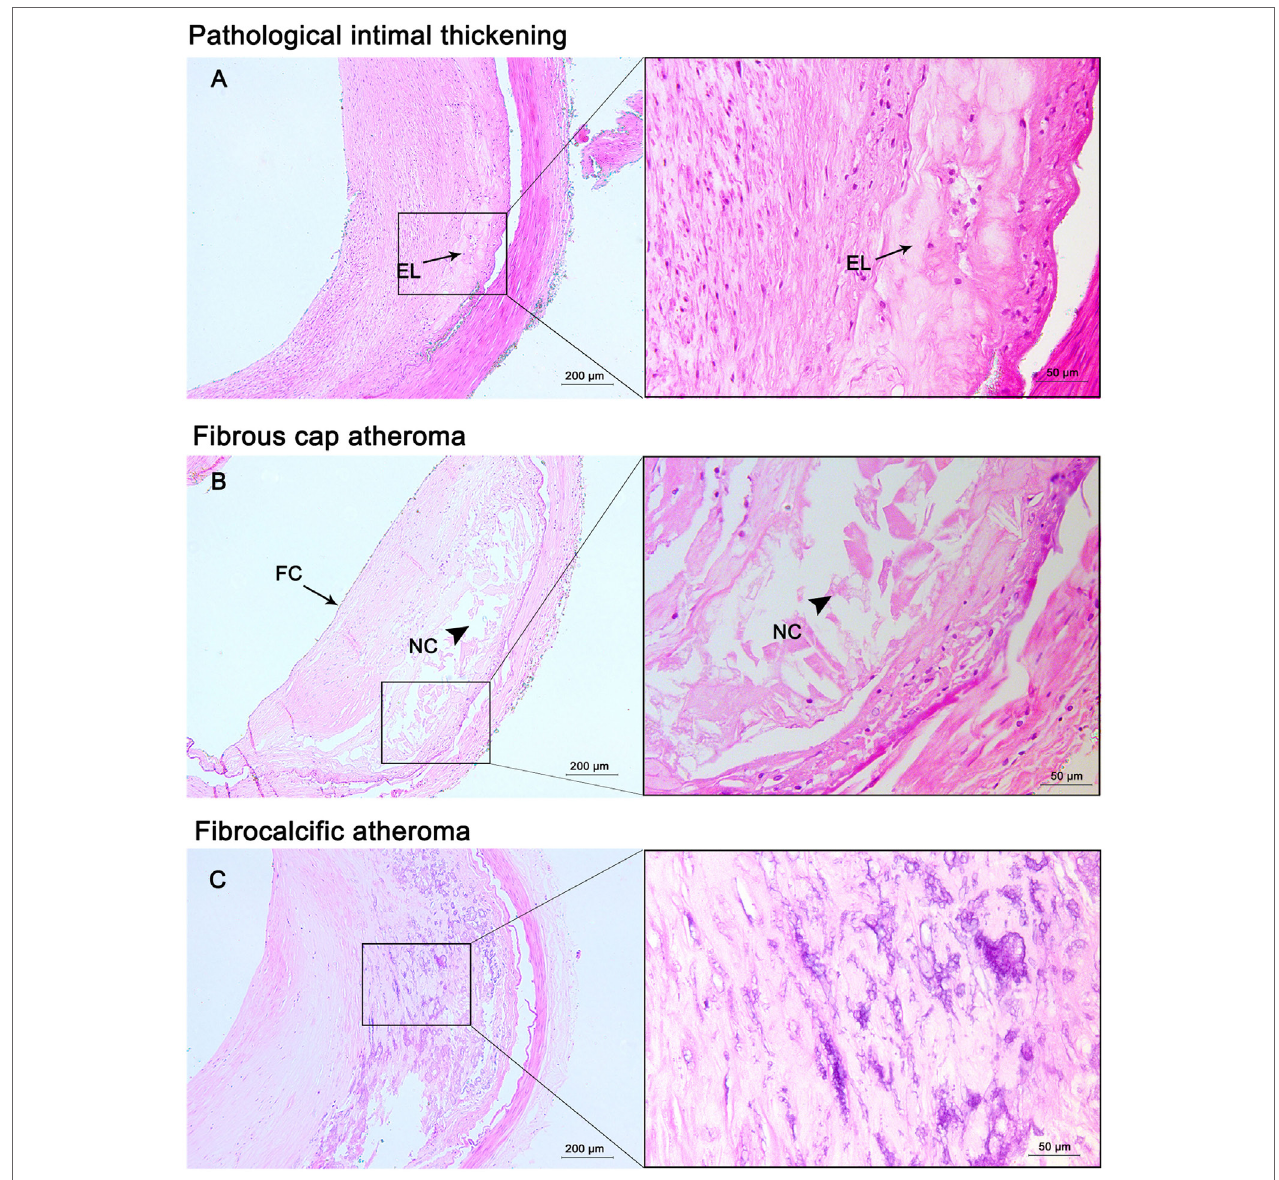
FigUre 2 | Progressive atherosclerotic lesions. Pathological intima thickening (a) has some extracellular lipid (EL) present deep in the lesion without true necrosis. Fibrous cap atheroma (B) has a well-formed necrotic core (NC) containing lipids with an overlying thick fibrous cap (FC). Fibrocalcific plaques (c) are heavily calcified lesions with or without a necrotic core. Hematoxylin and eosin (H&E) staining; original magnification: 5 × for original images, 20 × for inserted